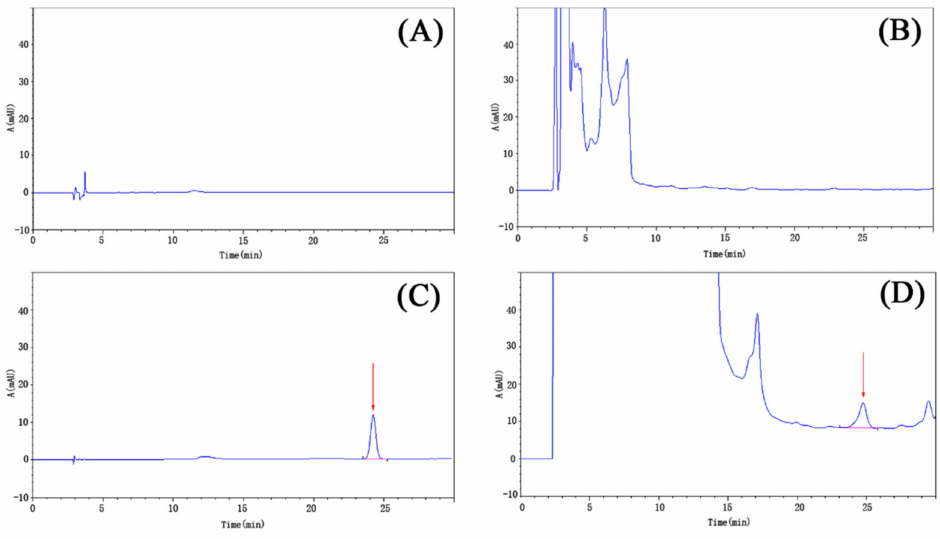
Figure 3. The high performance liquid chromatography (HPLC) chromatograms of 1-methyl hy- dantoin pre-column derivatization. ( A ) blank control; ( B ) negative control; ( C ) benzoyl-1-methyl hydantoin (bzmh) standard; ( D ) sample.